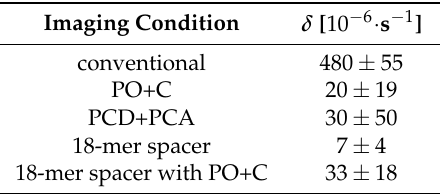
Table 2. Slope of the linear fit of Equation (4) to the depletion rate κ ( ρ ) in Figure 2. The errors represent the 95% confidence bounds of the